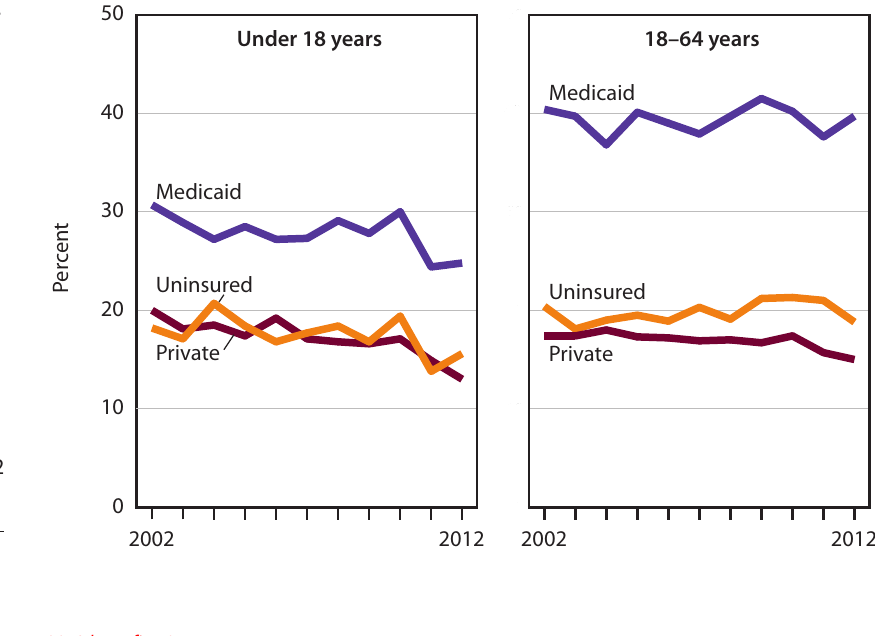
Figure 16. One or more emergency department visits in the past 12 months, by coverage were more likely to have at least one age and type of coverage: United States, 2002–2012 emergency department visit in the past